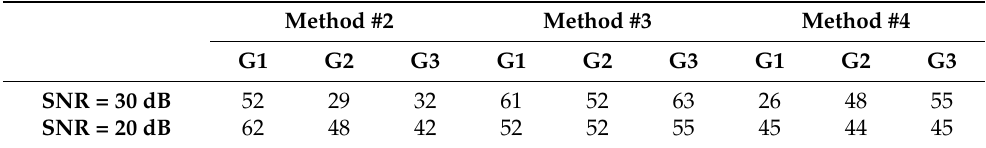
Table 7. Number of cases that Method #2, Method #3, and Method #4 failed to provide inertia estimates. K is assumed constant and equal to the corresponding mean values reported in Table